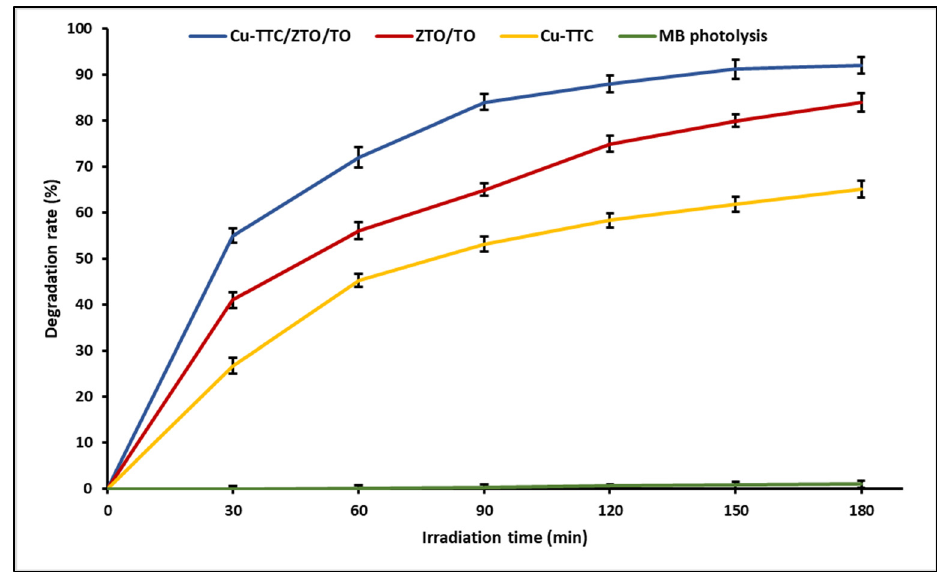
Figure 5. Photocatalytic degradation activity of Methylene Blue (MB) for photocatalyists Cu- TTC/ZTO/TO, ZTO/TO and Cu-TTC.